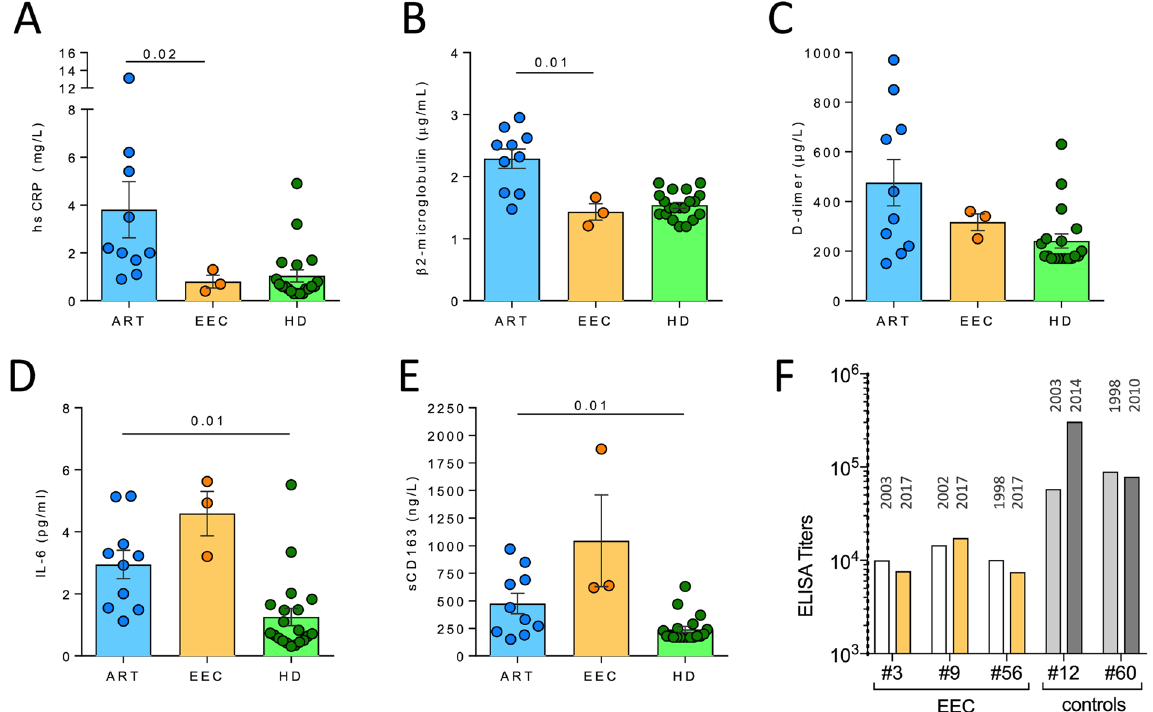
Figure 4. Inflammation biomarkers and antibody titers. ( A – E ) Different inflammatory markers were analyzed including ( A ) hsCPR, ( B ) β 2-microglobulin, ( C ) D-dimer, ( D ) IL-6 and ( E ) sCD163. EEC individuals were compared with HIV-1-infected individuals on ART and non-HIV-1-infected healthy donors (HD). ( F ) Plasma antibody titers, expressed as the inverse of the final serum dilution with a positive signal, in two samples 14 to 19 years